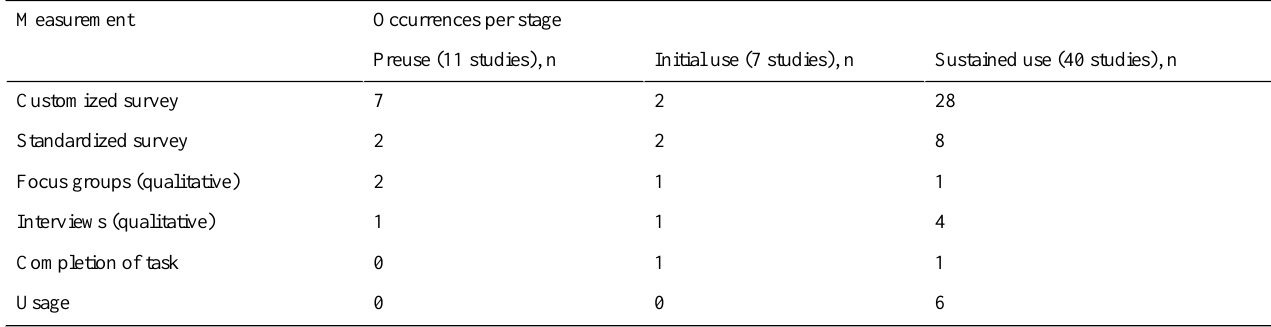
Table 3. Measurements performed (some studies performed several measurements). Occurrences per